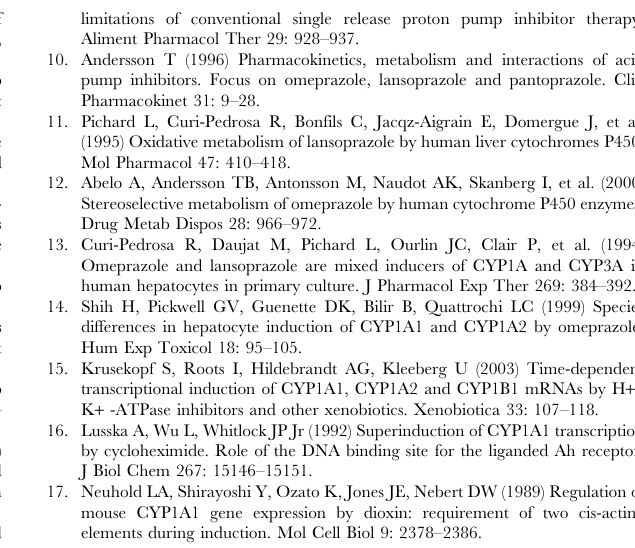
Figure 3. Effects of omeprazole and lansoprazole enantiomers on CYP1A1 mRNA, protein and EROD activity in primary human hepatocytes. Panel A and Panel B: RT-PCR analyses of CYP1A1 and CYP1A2 mRNA and western blots of CYP1A1 and CYP1A2 from two different cultures (HH52 and Hep220770) are shown. Human hepatocytes were incubated for 24 h (mRNA analysis) or 48 (protein analysis) with S-OME, R-OME, rac-OME, S-LAN, R-LAN, rac-LAN, TCDD and vehicle (DMSO; 0.1% v/v). RT-PCR data are the mean 6 SD from triplicate measurements and are expressed as fold induction over vehicle-treated cells. Data were normalized to GAPDH mRNA levels. Density of bands in western blots was quantified by densitometry and the values are indicated along with respective blots. Panel C: EROD and cytotoxicity: Human hepatocytes (culture Hep220774) were treated for 24 h with S-OME, R-OME, rac-OME, S-LAN, R-LAN, rac-LAN, TCDD and vehicle (DMSO; 0.1% v/v). Upper bar graph: An activity of 7- ethoxyresorufin- O-deethylase (EROD) was measured by fluorescent spectrophotometry with 530 nm excitation and 590 nm emission filters. Treatments were performed in triplicates. The data are expressed as fold induction over the value from control cells. Lower bar graph: A conventional MTT test was performed and absorbance was measured at 540 nm. Treatments were performed in triplicates. The data are expressed as percentage of viability of control cells. An asterisk (*) indicates that the value is significantly different from the activity of DMSO.